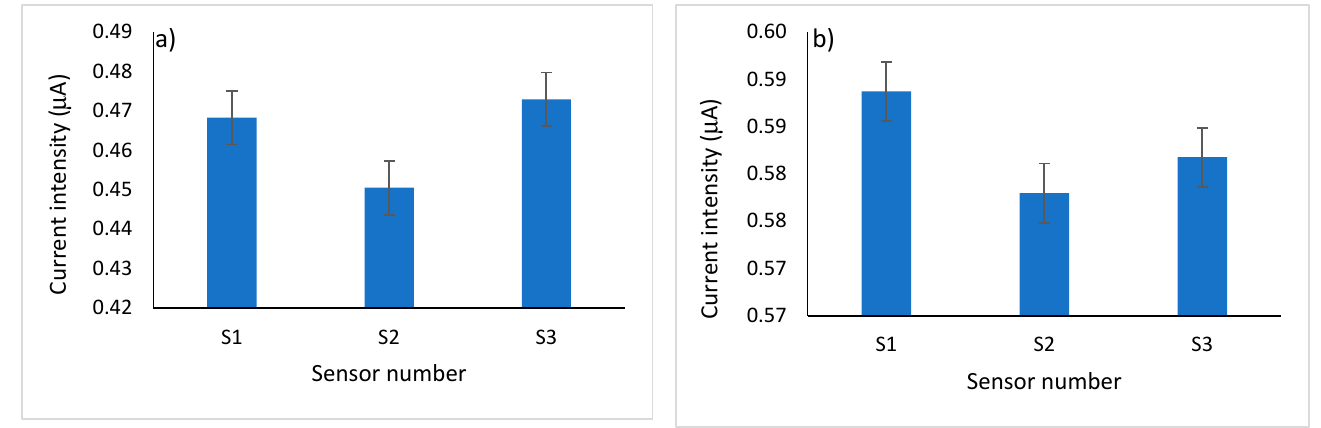
Figure 8. Reproducibility of the ( a ) TPP/rGO@Pd0 and ( b ) Fe(TPFPP)Cl/rGO@Pd0 sensor .